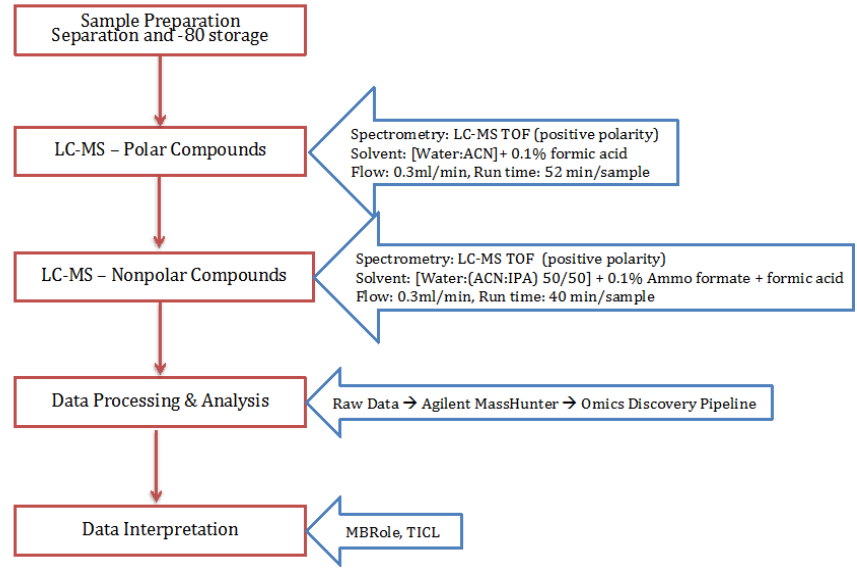
Figure 5. Flowchart for the method followed for the extraction, isolation, and detection of small molecules (general metabolites and